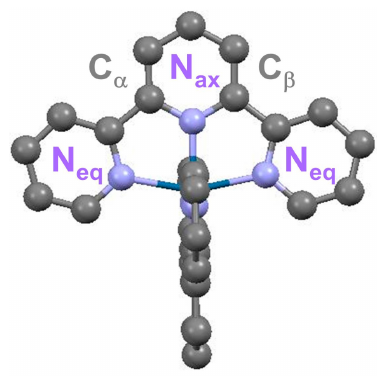
Figure 1. Molecular structure of [Os(terpy) 2 ] 2+ .